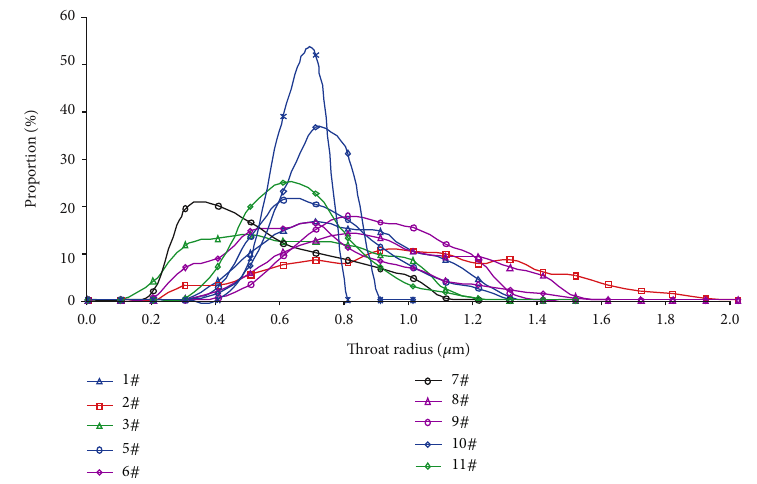
Figure 5: Probability curves of throat radius from 11 samples of He8.